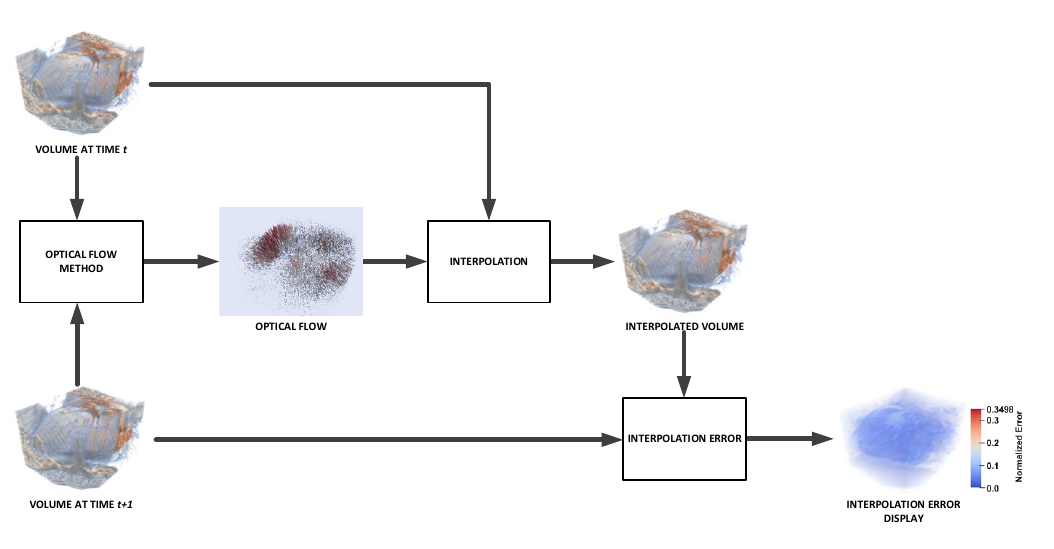
Figure 9. Steps to calculate and visualize the Interpolation